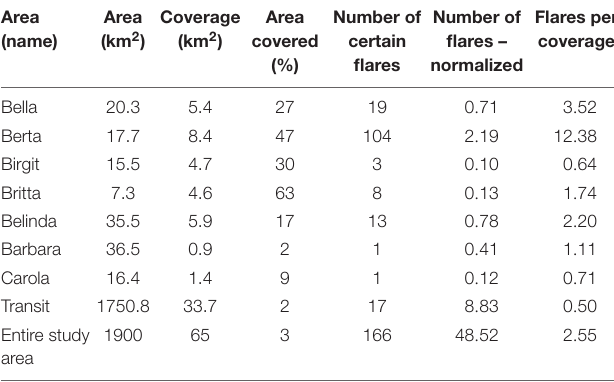
Flare numbers were normalized accounting for the area covered during HE537. The calculated values for flares per coverage illustrate that areas Bella and Berta are above the average of other areas and the entire study